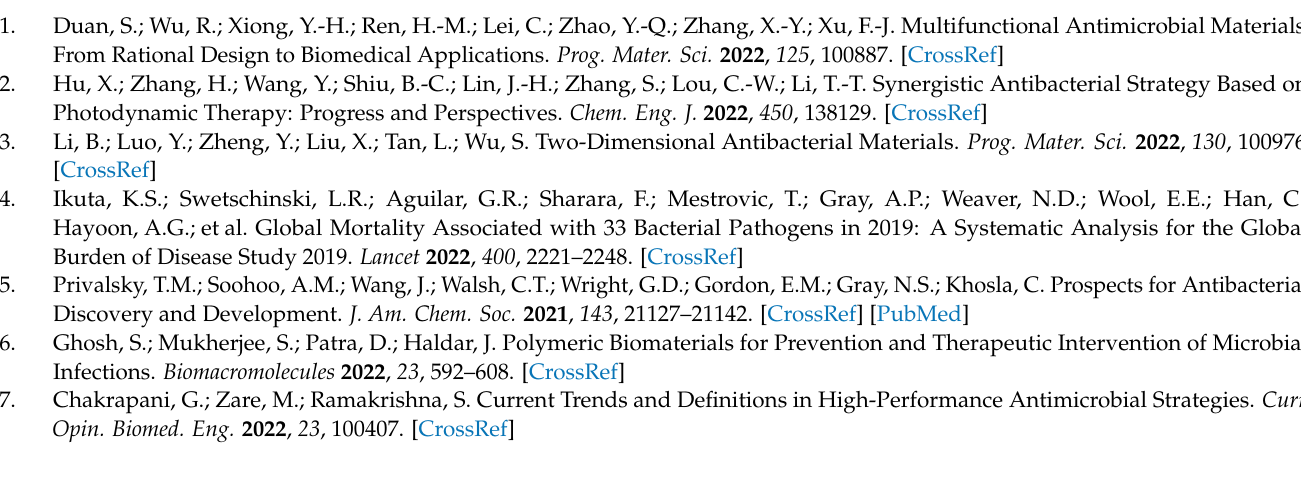
Figure S2. Different morphologies of ZIF-L crystals in SEM tests.; Figure S3. XPS spectra of ZIF-L: (a) full survey spectrum, (b) C 1s spectra and (c) N 1s spetra.; Figure S4. FT-IR spectrum of NCDs@ZIF- L composites compared with ZIF-L (a) and NCDs (b).; Figure S5. (a) UV-Vis spectra of dissolved 2- methylimidazole in DI water at different concentrations; (b) a calibrated standard curve for determining the concentration of ligands in water.; Figure S6. Results of antibacterial rates of ZIF-L and NCDs@ZIF-L composites against E. coli (a) and S. aureus (b).; Figure S7. Images of bacteria stained with 33342 dye (a) and PI staining (b) under visible light after materials